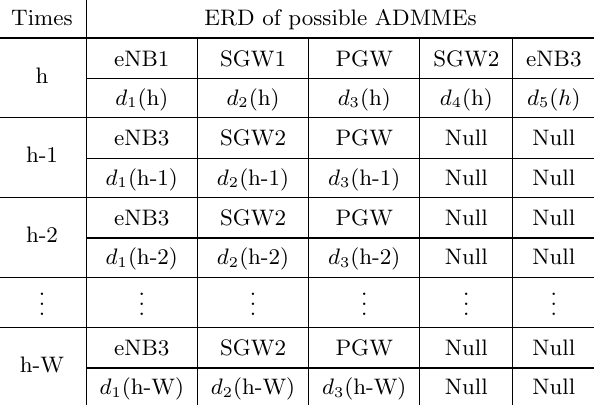
Table 1: An example of the history of ERDs Times